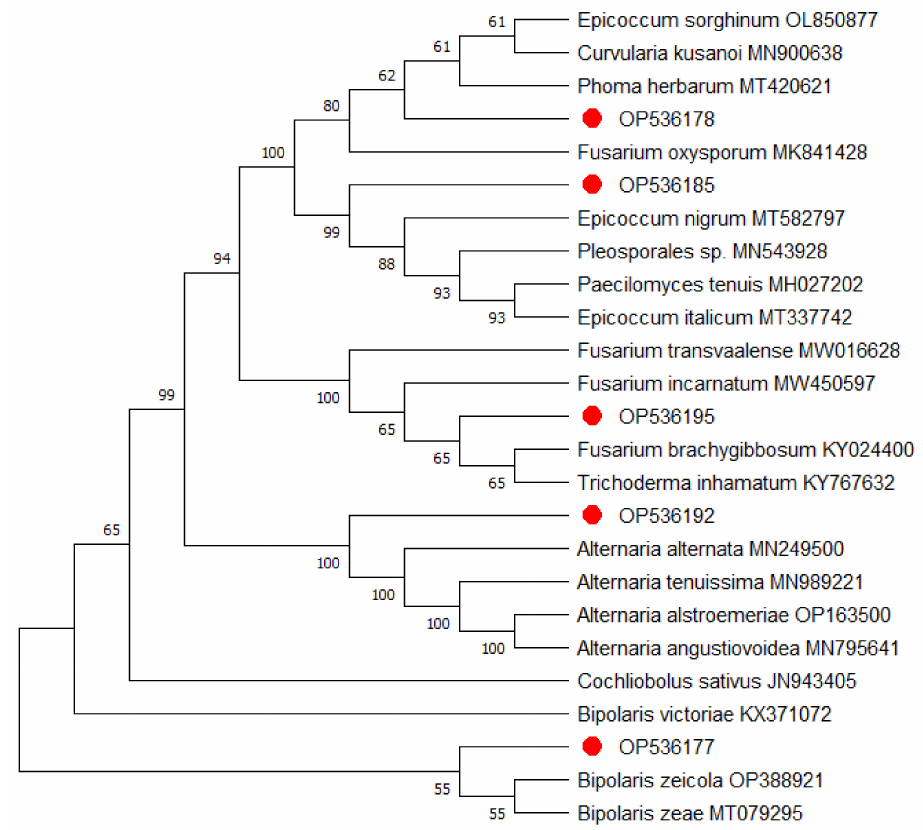
Figure 5. The phylogenetic relationships between the isolated pathogenic fungi and selected database relatives on the NCBI generated through transcribed spacer (ITS) rRNA genes, analysed via Kimura’s two-parameter models. Bootstrap support values higher than 50% from 1000 replicates are shown at the nodes. Bipolaris zeae (MT079295) was used as the